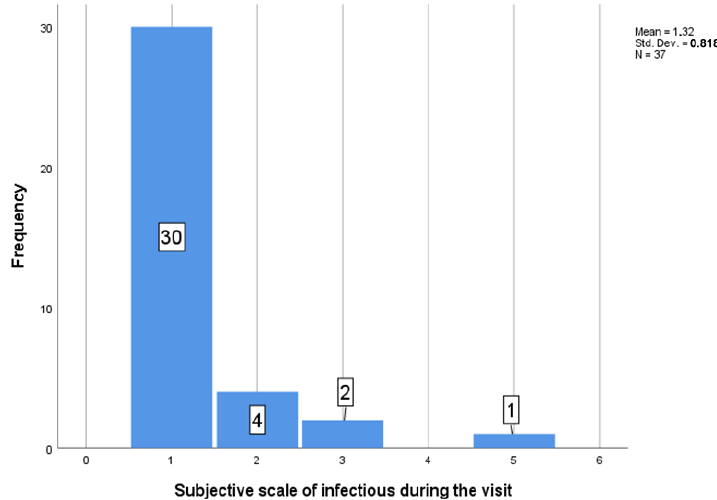
Figure 8. Number of subjective infectious status during visit.